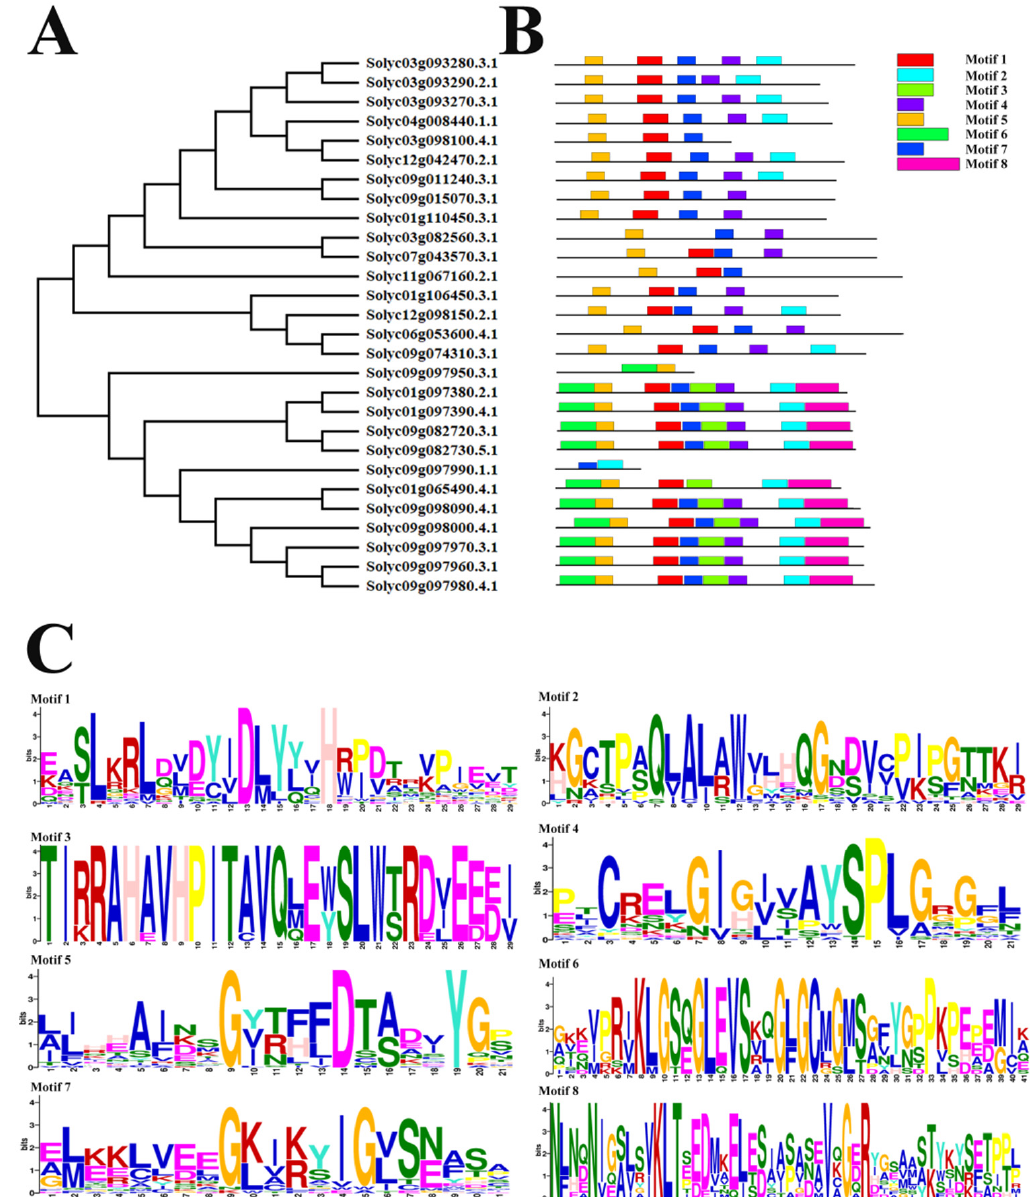
Figure 4. Phylogenic tree of protein and motifs for the SlAKR family. ( A ) Phylogenic tree of SlAKR protein by the neighbor-joining method in MEGA11 with a bootstrap of 1000; ( B ) Motif analysis of each SlAKR protein by MEME. Differently colored boxes represent different motifs; ( C ) The amino acid sequence logo of each motif in SlAKR proteins. The size of the letters represents the frequency of